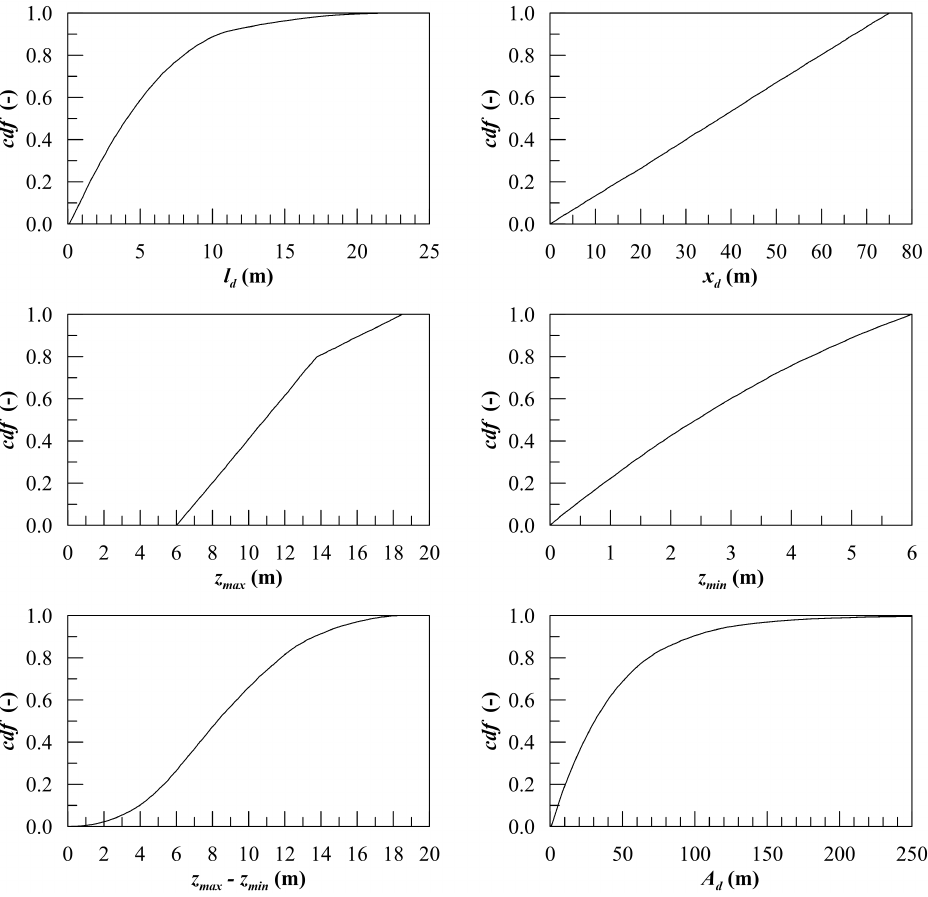
Figure 8. Cumulative density functions of main damage characteristics in the MC50b